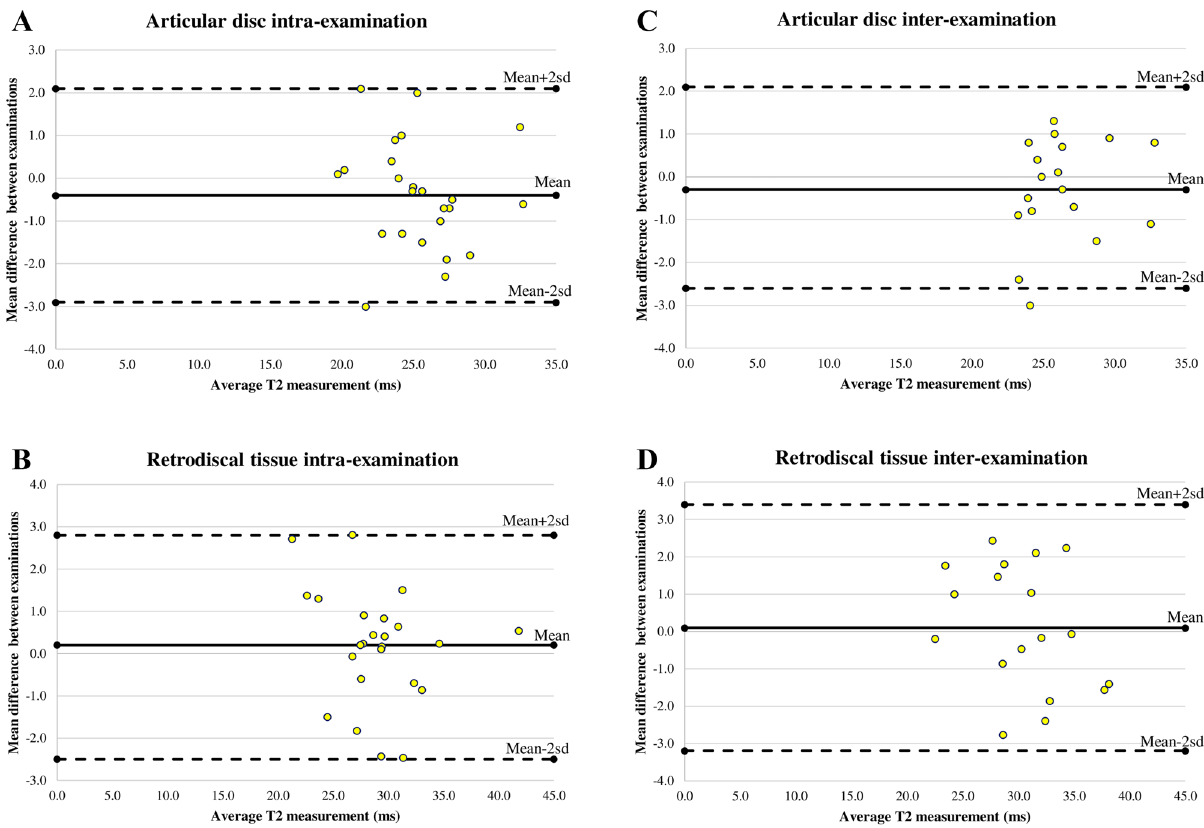
Figure 1. Bland–Altman plots for ( A ) intra-examination reproducibility of the articular disc, ( B ) intra- examination reproducibility of retrodiscal tissue, ( C ) inter-examination reproducibility of the articular disc, ( D ) inter-examination reproducibility of retrodiscal